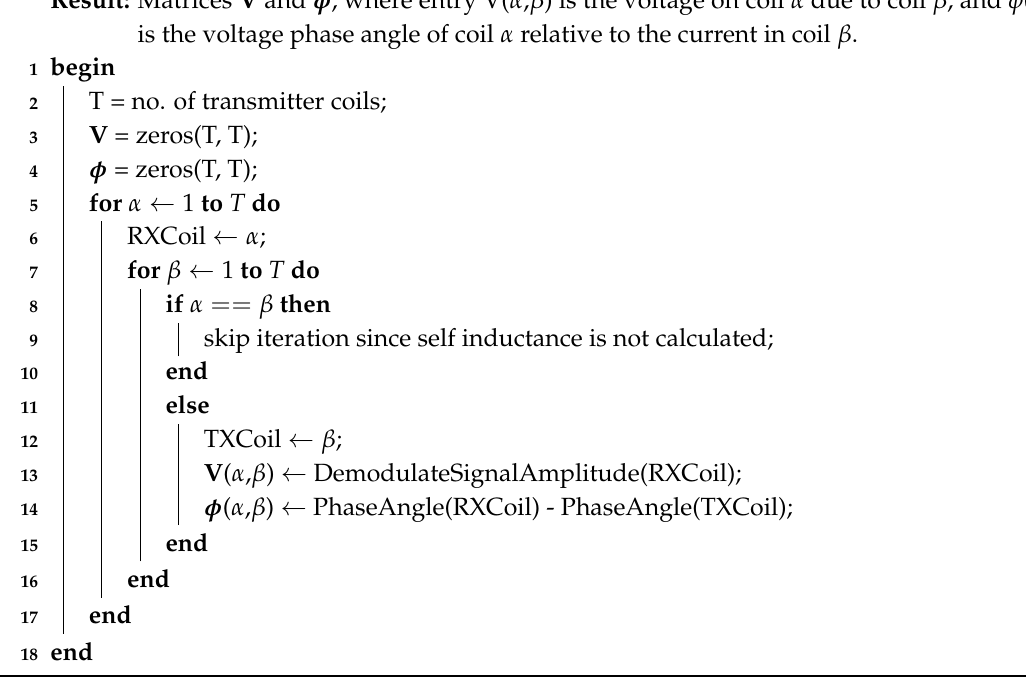
Algorithm 1: Coil switching and acquisition procedure. Acquisition is skipped if indices α = β since this matrix entry represents a coil’s